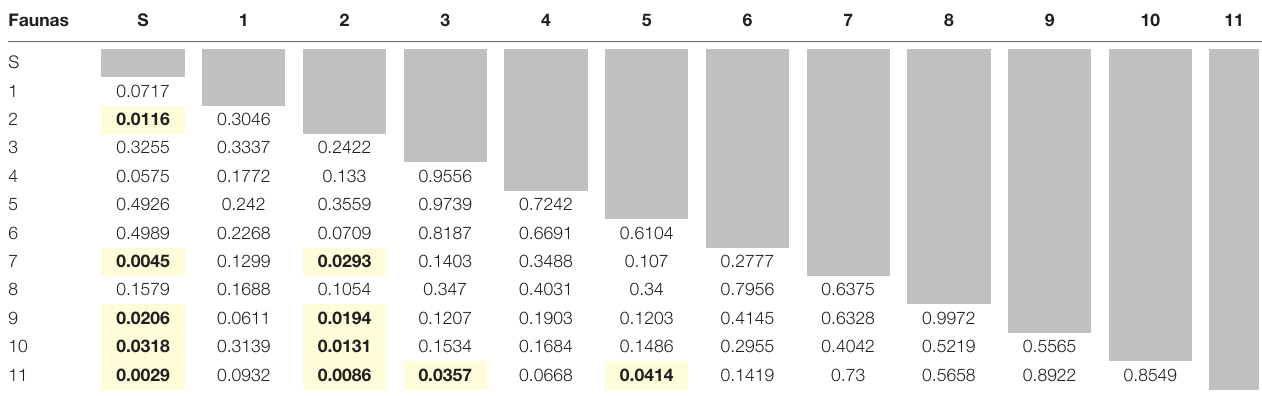
TABLE 6 | Summary of one way PERMANOVAs run with all row scores obtained from the correspondence analysis (permutation N = 9999) to test for differences between the modern-day Serengeti (here labeled fauna S) and Neogene faunas, as well as between Neogene faunas.